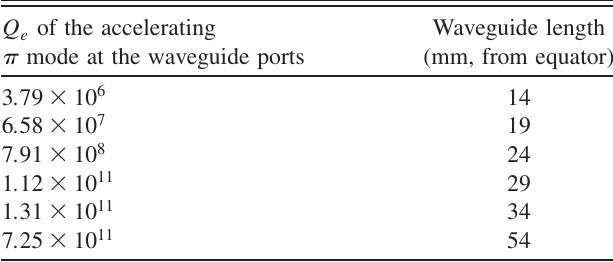
TABLE II. Q e of the accelerating (cid:3) mode at the waveguide ports for different waveguide lengths. Q e of the accelerating (cid:3) mode at the waveguide ports